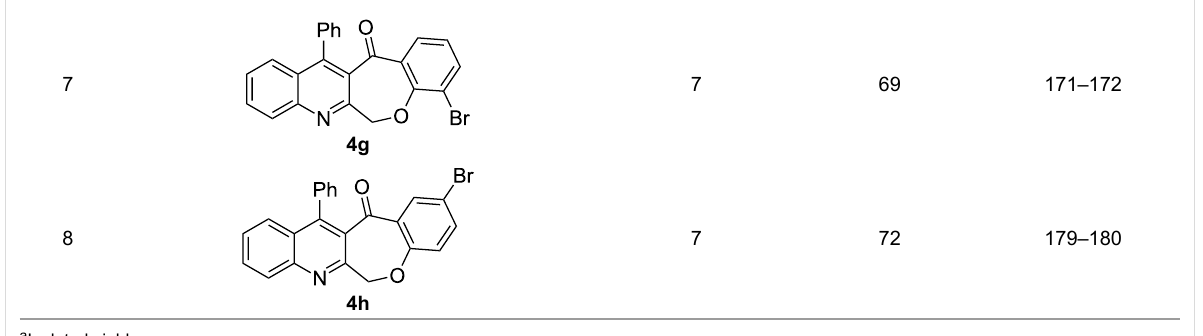
Table 2: Structures and yields of the cyclized products 4a – h .